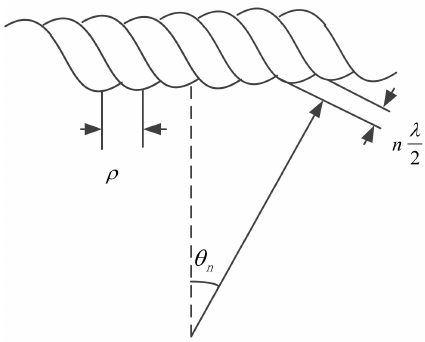
Figure 7. Bragg scattering principle of power lines.